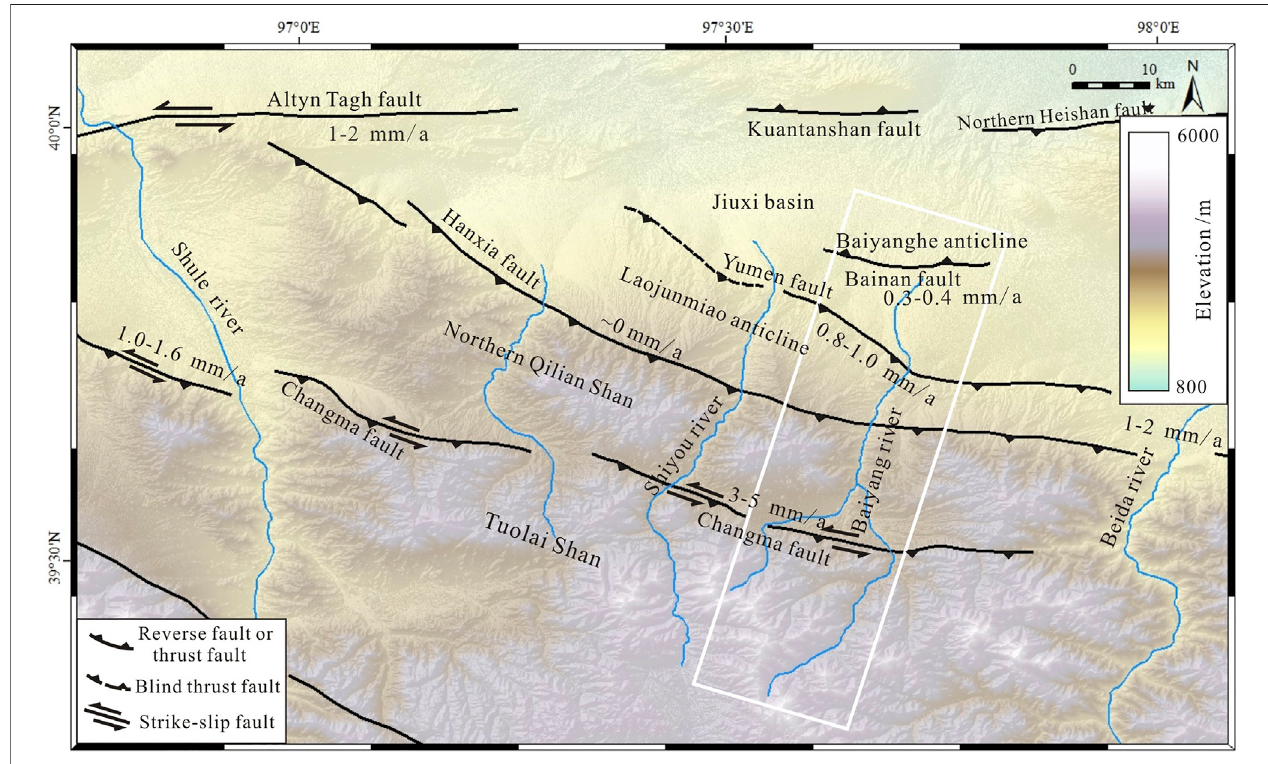
FIGURE 2 | The tectonic map of the northwestern Qilian Shan showing the slip rates of the active faults. The range of the map is shown in the white rectangle of Figure 1B . The white frame in this map shows the Baiyang river study area covering the range of Figures 4A , 8A .